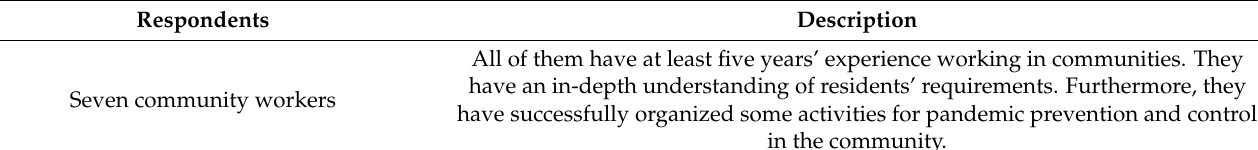
Table 2. Description of respondents in the user interview.